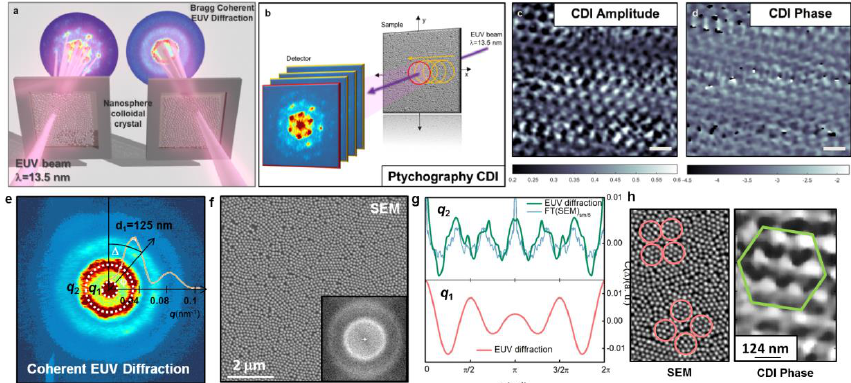
Fig. 1. (a) X-ray scattering and microscopy of silica nanosphere colloidal crystals with different ordered and structure. (b) Schematic of transmission-mode EUV ptychography. (c, d) Reconstructed quantitative amplitude and phase. The scale bars are 250nm. (e) Coherent diffraction pattern of a silica nanosphere monolayer. (f) SEM image of the sample. Inset: FT simulation of the SEM image. (g) Angular cross-correlation analysis at q 2 (top) and q 1 (bottom). (h) Left: visualization of four-fold arrangement of grains of silica nanospheres in the SEM image. Right: the reconstructed phase confirms the hexagonal arrangement of nanospheres within grains in the colloidal crystal and yields at nanosphere thickness of